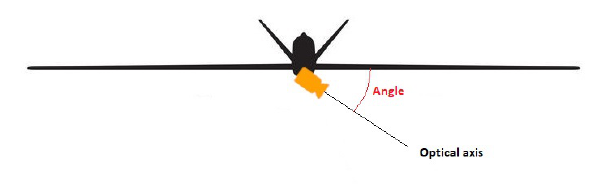
Figure 5. UAV camera position on the UAV showing the angle of the optical axis (direction where the camera is targeted) relative to the plane of the UAV. An angle of 90 ◦ between the two means that the camera is pointing directly downwards. (Source: